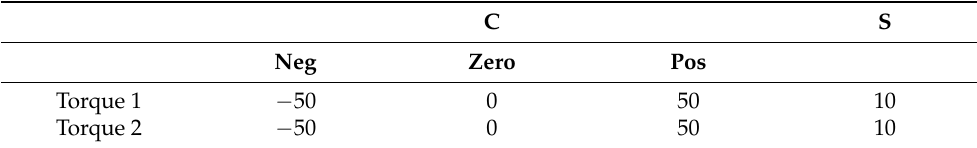
The surface generated to control the right (Torque 1) and left (Torque 2) wheels can be seen in Figures 8 and 9, respectively.